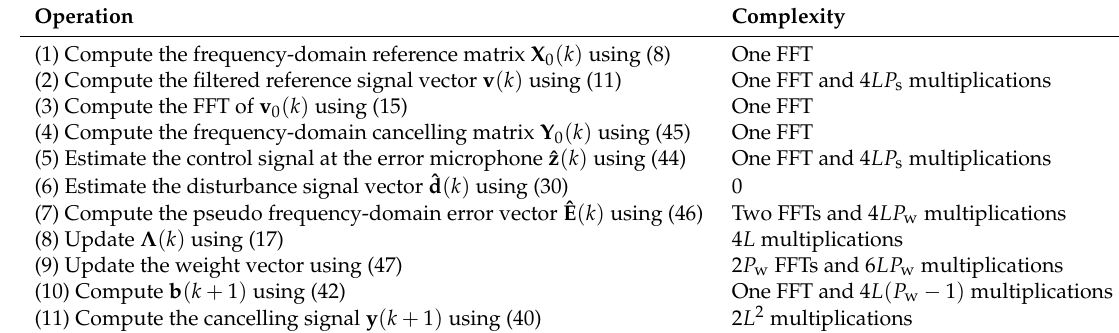
Table 8. Proposed delayless